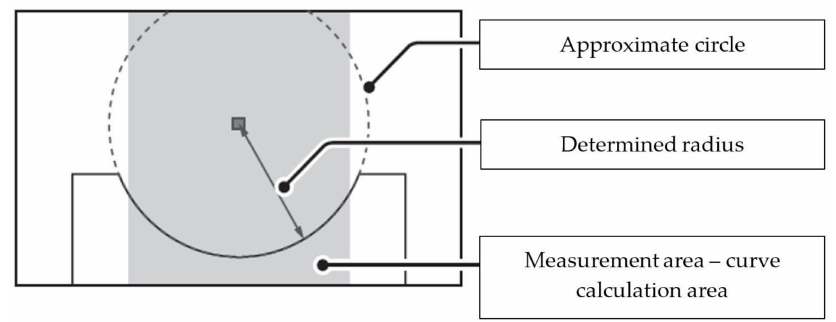
Figure 16. The concept of radius determination in the predefined measurement area. For the vision system, the search of the curve that crossed each measurement point would be incorrect and lead to false conclusions in the analysis. The model applied to approximate the measurement data can have different forms; however, the form used most often is low-degree polynomials. For the fillet radius inspection, a 2nd-degree polynomial approximation is used, an equation of a circle